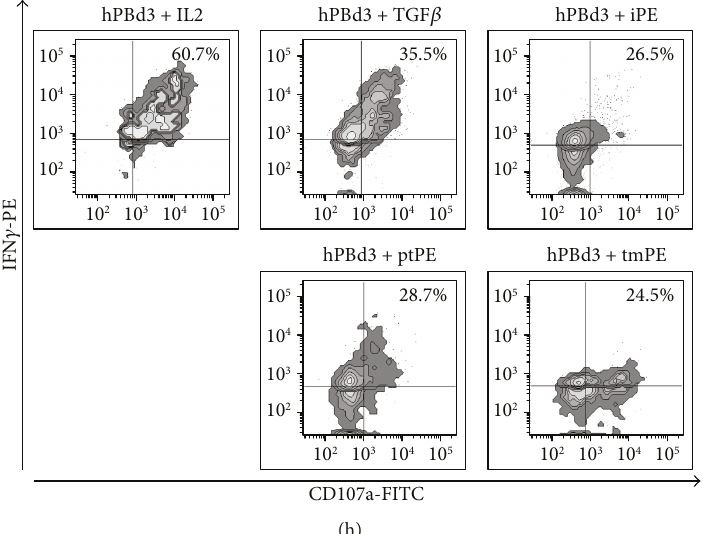
Figure 6: Induction of NK cell anergy by TGF β or PE fl uids in the presence of IL-2. IL-2, TGF β , or autologous PE fl uid treatment of NK cells, both from autologous or healthy control-derived NK cells, was performed every 2 days starting from day 0 (D0) for three days as shown by the timeline (a). At day 3 (D3) following coculture with target K562 cells, CD107a modulation was detected by fl ow cytometry. After IL-2 exposure, PB-NK and PE-NK from patients with PE showed an enhanced cytotoxic potential associated with an increased expression of CD107a. The addition of TGF β or in fl ammatory or metastatic PE supernatants strongly inhibited the IL-2-induced stimulation, inducing a downregulation of CD107a surface marker (b – d). Data are shown as mean ± SEM of 38 samples; ∗ p < 0 05 , ∗∗ p < 0 01 , and ∗∗∗ p < 0 001 ( p values are shown). These results were con fi rmed by polarizing healthy control-derived NK cells with heterologous PE fl uids (e – h). The addition of TGF β , iPE, ptPE, and tmPE fl uids signi fi cantly inhibited the percentage of cells expressing CD107a and IFN γ and reduced the IFN γ MFI (f, g). Representative dot plots of CD107a + IFN γ + expression in healthy donors treated with IL-2 and with or without TGF β , iPE, ptPE, and tmPE fl uids (h) after exposure to target K562 cells. Data are shown as mean ± SEM of 12 samples; ∗ p < 0 05 , ∗∗ p < 0 01 , and ∗∗∗ p < 0 001 ( p values are